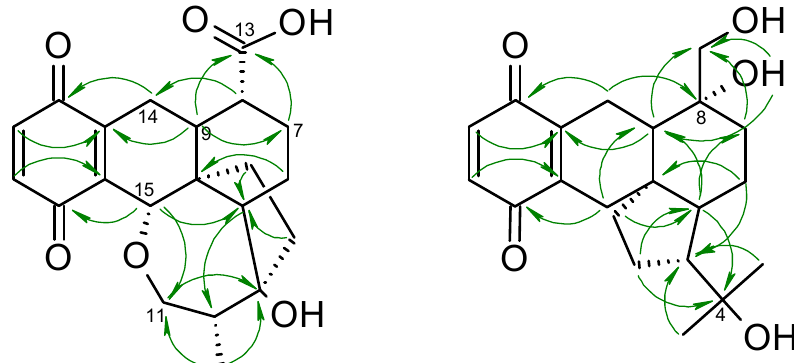
Figure 3. Selected 1 H, 13 C-HMBC correlations of 3-Hydroxy-dihydropleurotinic acid ( 5 ) and 4-Hydroxy-pleurogrisein ( 11 ).